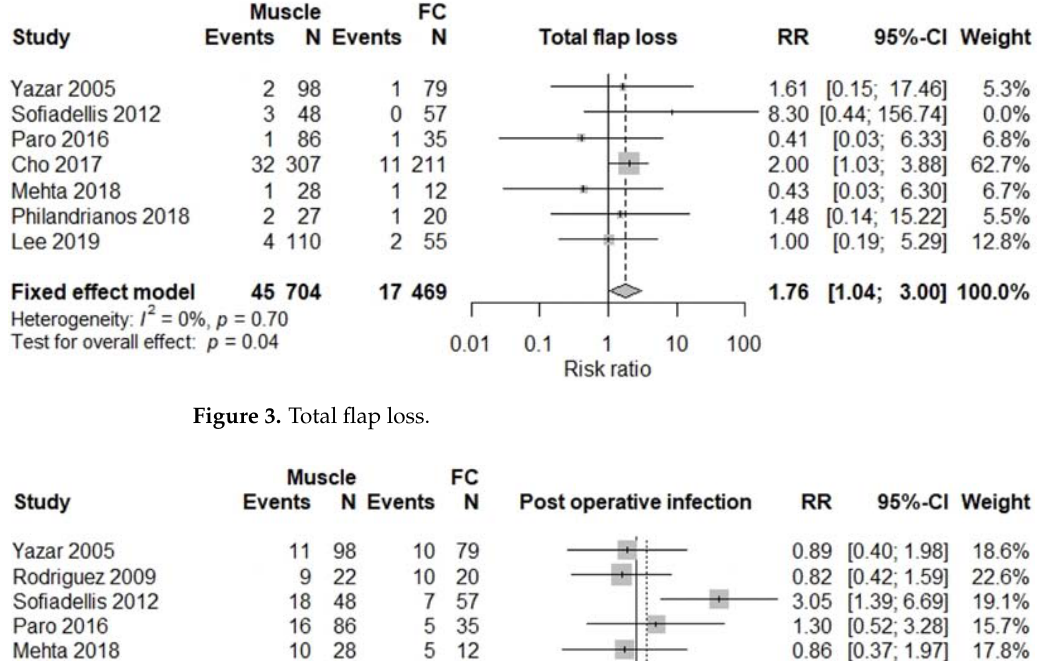
Figure 2. Donor site morbidity.